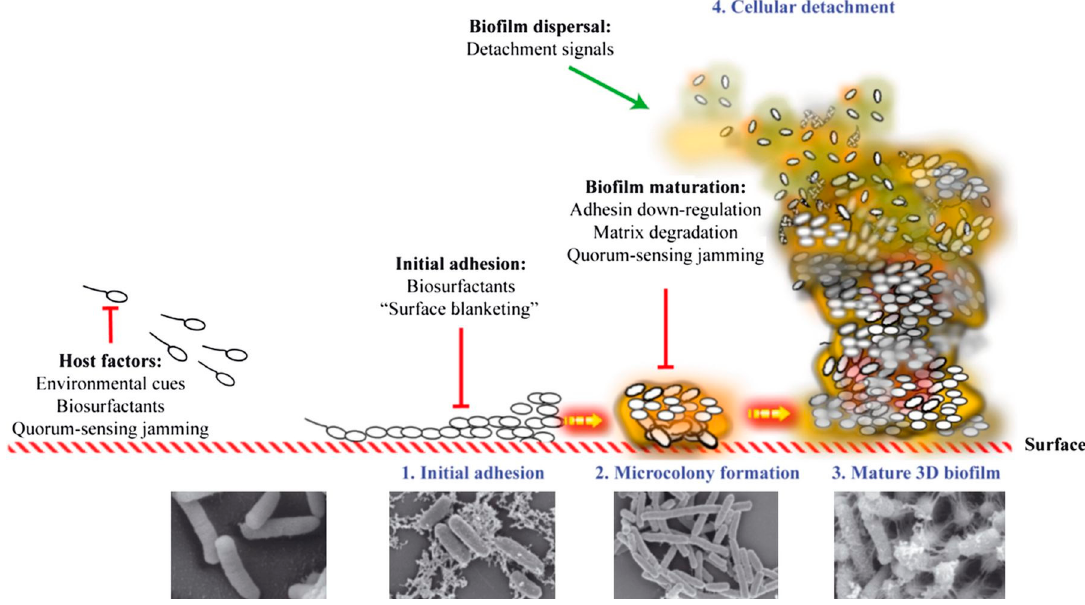
Figure 1. Stages in the biofilm formation process, including scanning electron microscopy imaging of each stage. Reproduced from [12], by permission of Oxford University Press and FEMS.